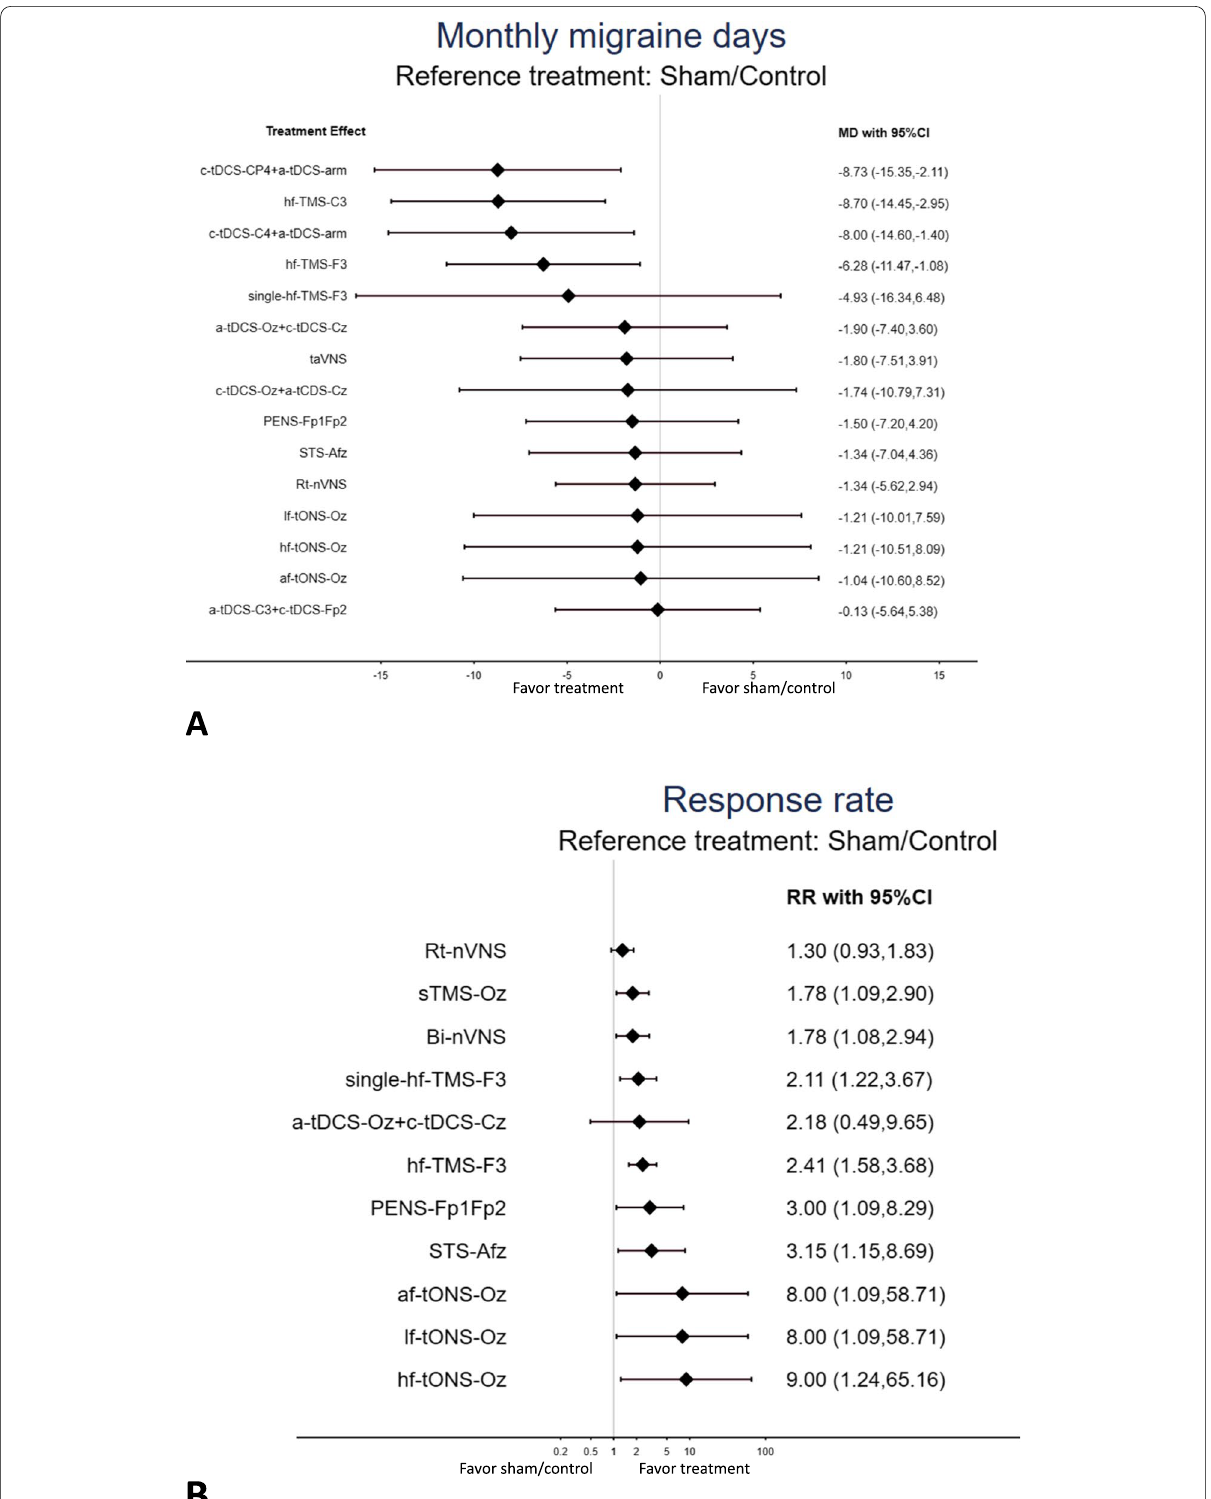
Fig. 3 Forest plot of primary outcome: ( A ) changes in monthly migraine days and ( B ) response rate. When the effect size was ( A ) < 0 (presented as the mean difference) or (B) > 1 (presented as the rate ratio), the specified treatment yielded (A) a better improvement in monthly migraine days or ( B ) a higher response rate than its corresponding sham/control group